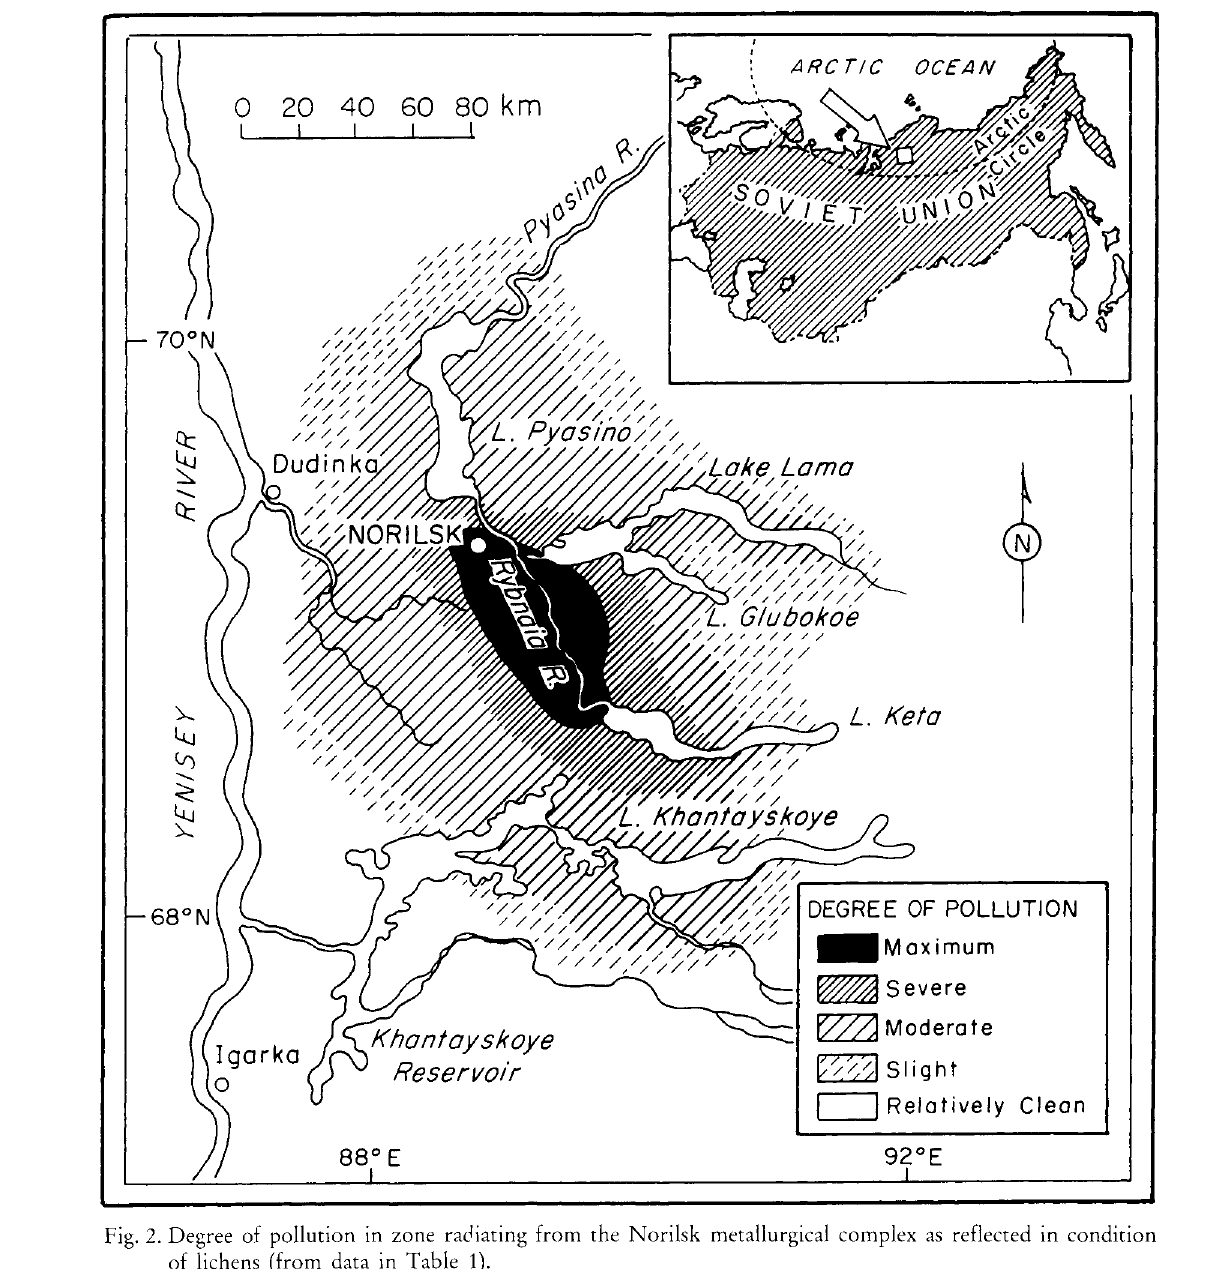
Fig. 2. Degree of pollution in zone radiating from the Norilsk metallurgical complex as reflected in condition of lichens (from data in Table